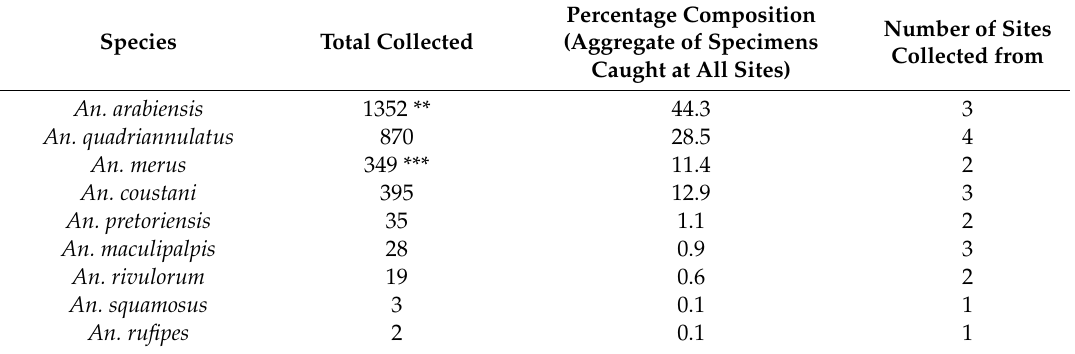
Table 6. Anopheles mosquitoes collected from five sites in the northern Kruger National Park, Limpopo Province, July 2010 to December 2012 [16]. Percentage Composition Number of Sites Species Total Collected (Aggregate of Specimens Collected from Caught at All Sites) An. arabiensis 1352 ** 44.3 3 870